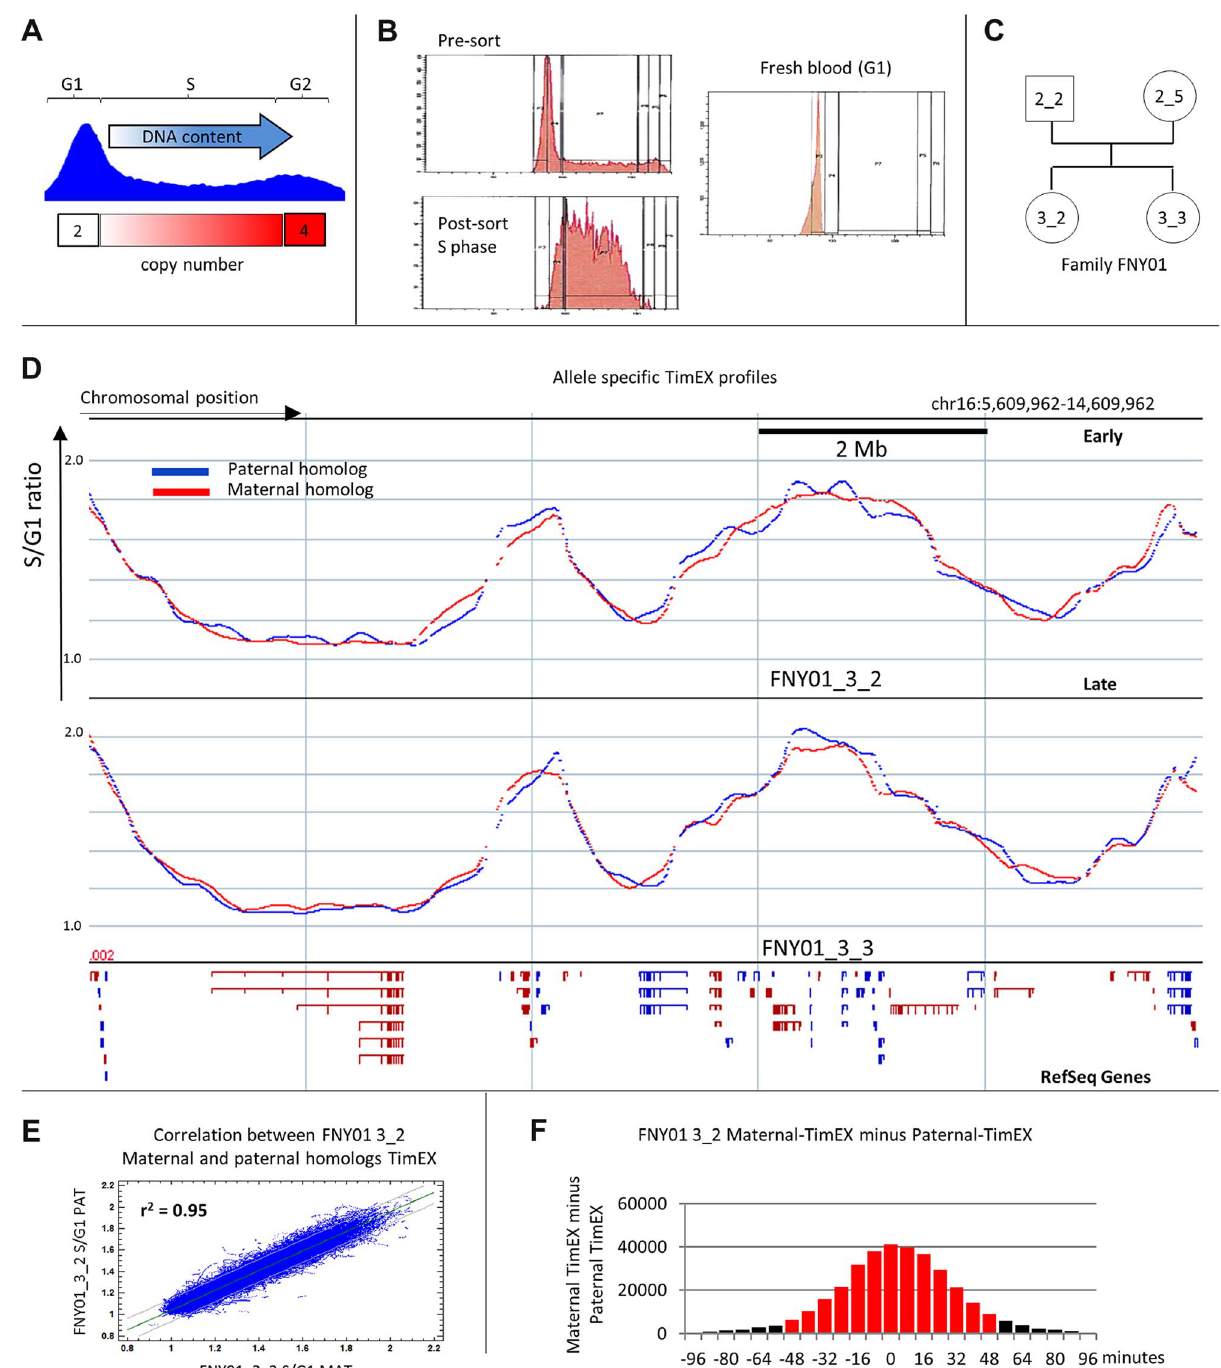
Figure 1. Allele specific timing profiles. A: Principle of the TimEX methods: DNA content from cells in the G1 and S phases of the cell cycle is compared. Cells in G1 contain 2 copies of each genomic region. By contrast, cells in S contain between 2 and 4 copies of each genomic regions and the number of copies in S is inversely proportional to replication timing. The S/G1 ratio can therefore be used as a surrogate for replication timing. B: Histograms representing the DNA content profiles of exponentially growing cultured basophilic erythroblasts (presort), of the same cells after sorting the S phase fraction (post sort) and of circulating white blood cells that are almost exclusively in the G1 phase of the cell cycle. Cells were labeled with Propidium iodide for 15 minutes. C: Pedigree of family FNY01. D. Plots illustrating the replication timing of the maternal and paternal homologs in a 10 Mb region on chr16 for FNY01 3_2 and 3_3. The data was generated by binning the read depth of heterozygous SNPs in 500 bp windows, applying a Gaussian smoothing filter (sigma=100 kp) and calculating the S/G1 ratio for the maternal and the paternal homologs. The profiles are discontinuous because some reion of the genome did not contains any heterozygous SNPs. Replication of the homologs is tightly regulated. The location of Refseq genes is indicated below the timing profiles to give a sense of scale. E: Scatter-plots of the S/G1 ratios of the allele-depth of heterozygous SNPs in 5 kb windows for the maternal and paternal homologs. Coefficient of correlation between the two homolog is very high (r 2 =0.95). F: Histogram of the distribution of the difference between the S/G1 ratio of the maternal and paternal homologs. The two homologs